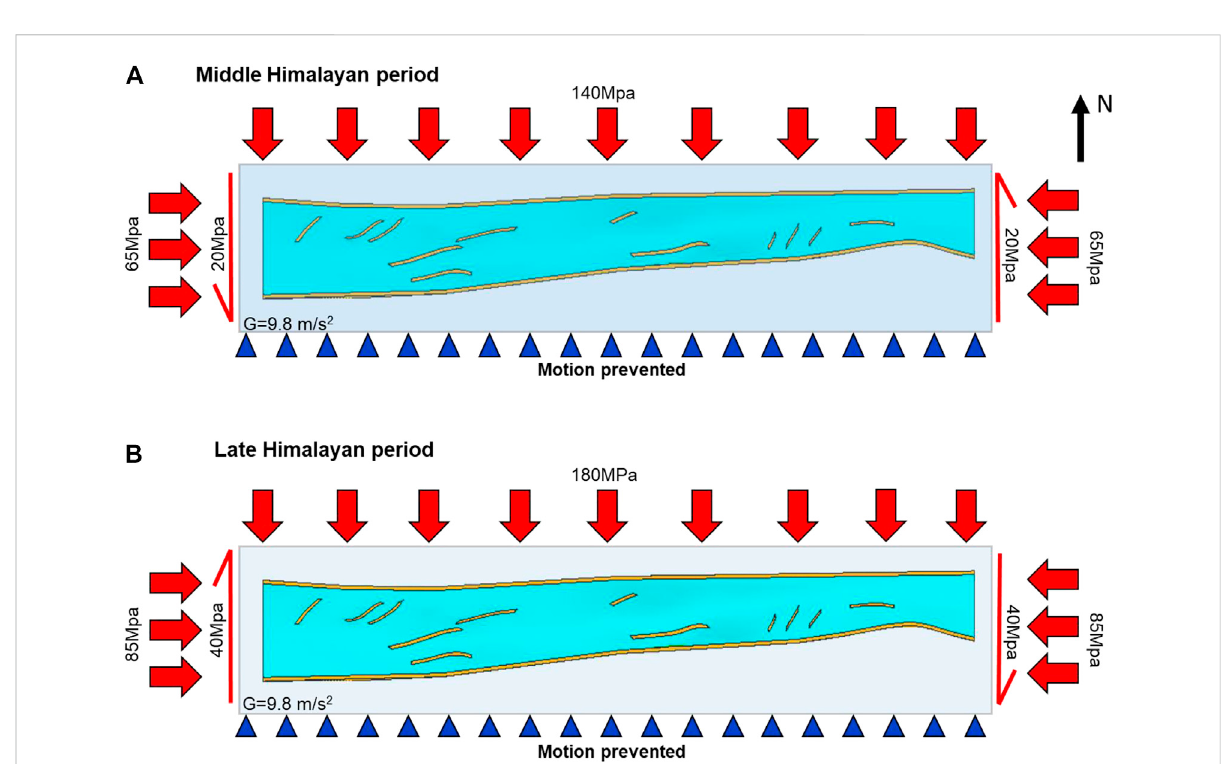
FIGURE 7 Mechanical model of tectonic stress fi eld simulation of study area. (A) Boundary condition in middle Himalayan period; (B) Boundary condition in late Himalayan period.